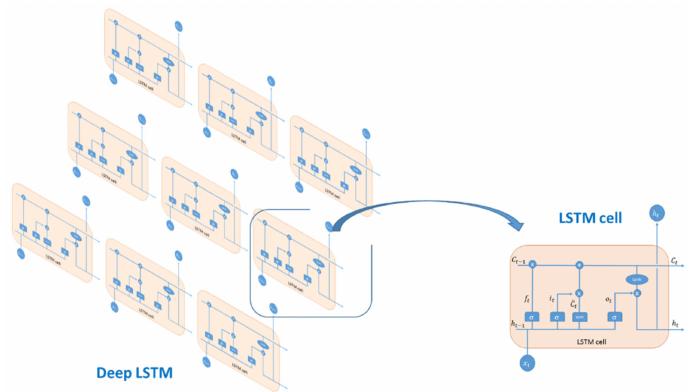
Figure 4. Deep LSTM model with a detail about the cell unit.